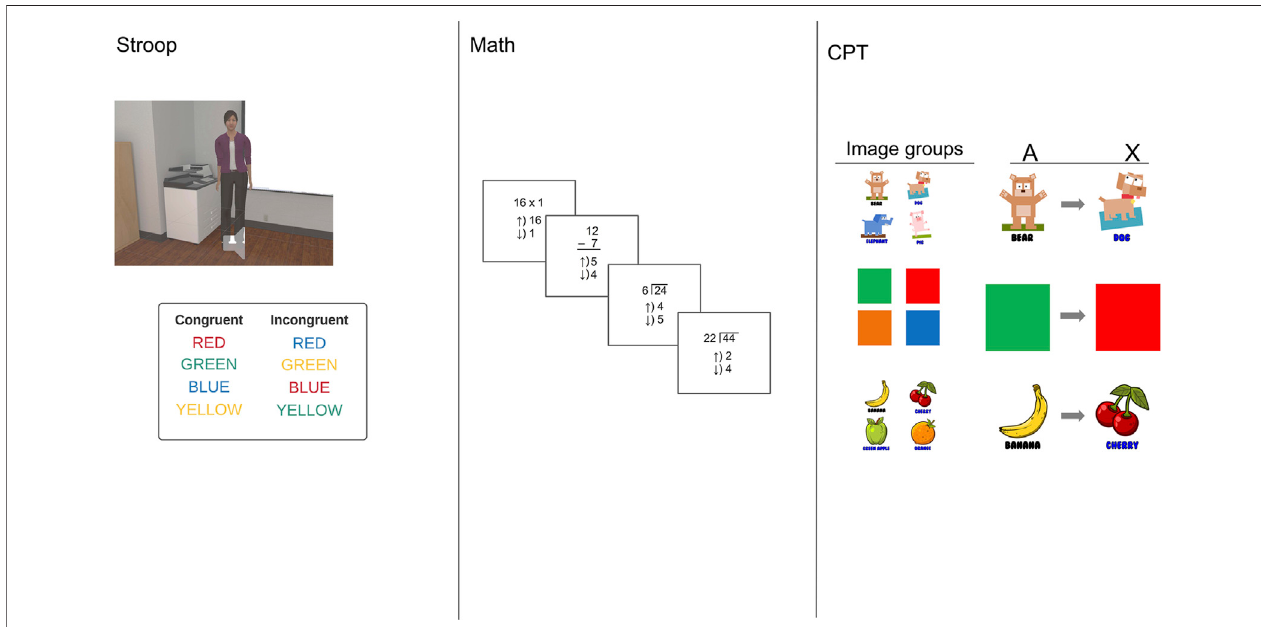
FIGURE2| Illustrationsofeachtaskpresentedonthewhiteboardatthefrontoftheclassroomnexttotheteacher( see leftmostpanel).Participantswereinstructed to focus on the whiteboard tasks and complete as many problems as accurately as possible.